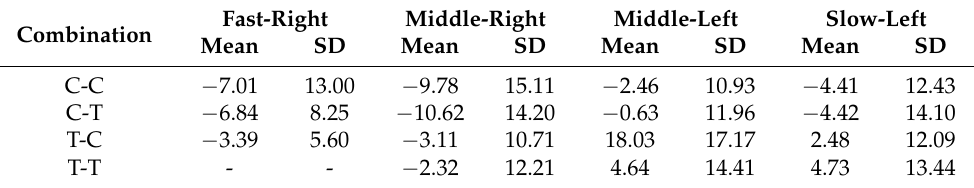
Table A4. The mean and standard deviation of ∆ V of m and n3.